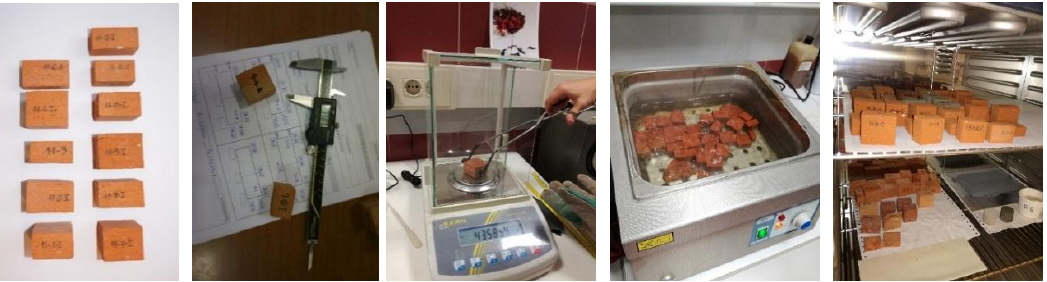
Figure 3. Measurement of the brick samples.